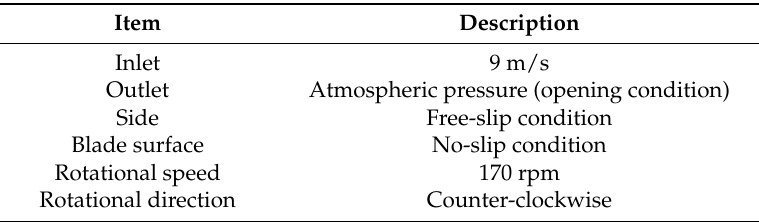
Table 4. Boundary conditions for 2D CFD analysis.